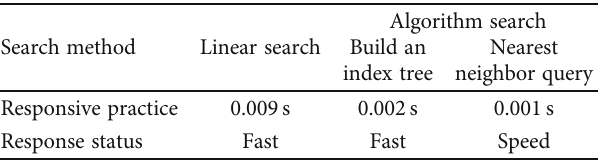
Figure 9 is a graph of experimental results of two ways.